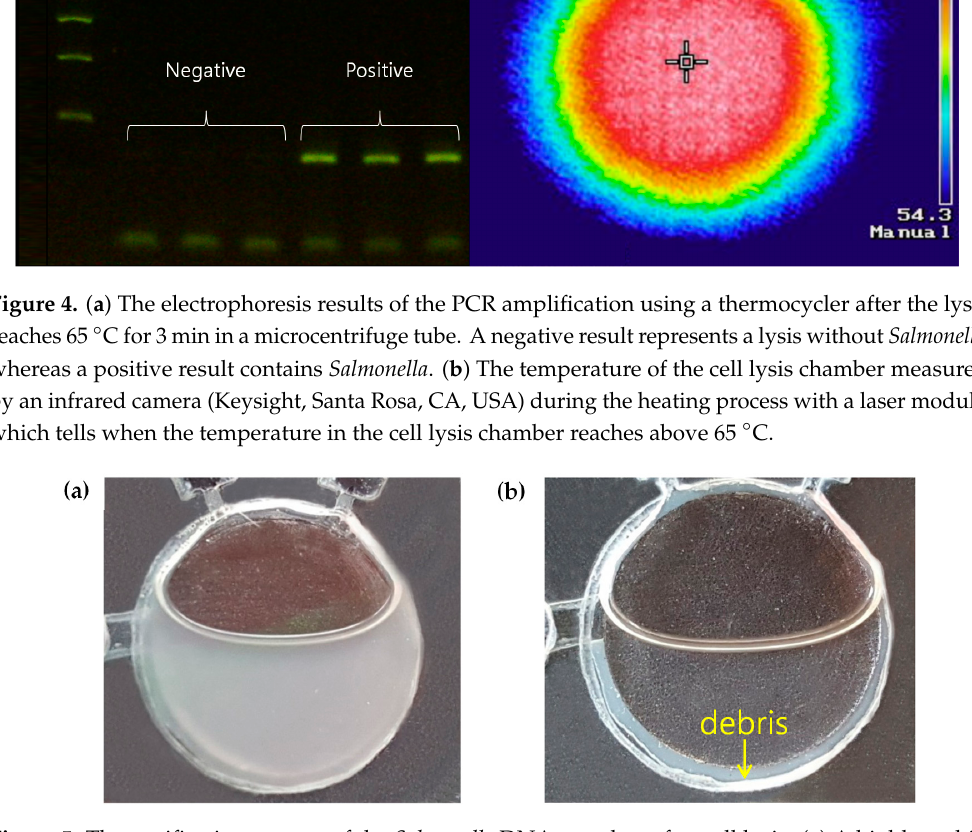
Figure 5. The purification process of the Salmonella DNA template after cell lysis: ( a ) A highly turbid solution of Salmonella before purification, ( b ) separation of the supernatant containing purified DNA from cell debris after LOD rotation.